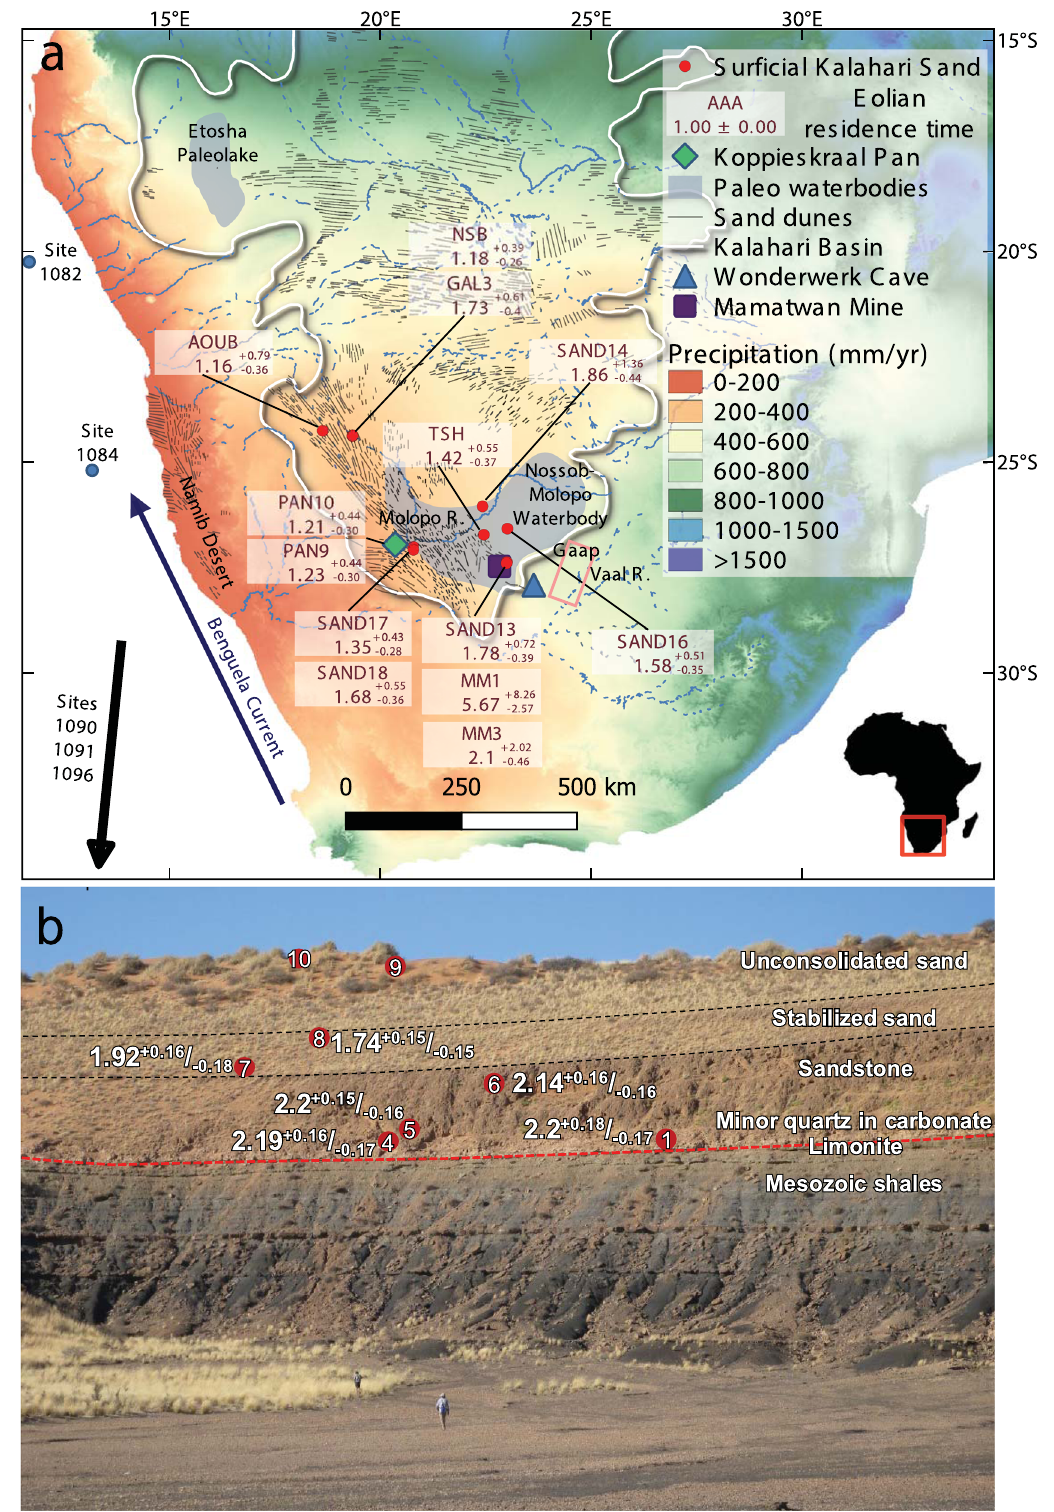
Fig. 1 | Eolian chronology of the Kalahari Desert Sand. a Locations of sand samples and sites mentioned in the text are superimposed on the modern pre- cipitation mapofsouthernAfrica (mapmade with QGIS. Climate data isfrom Fick, S.E. and R.J. Hijmans. WorldClim 2: new1kmspatial resolution climate surfaces for global land areas. International Journal of Climatology 37 (12): 4302 – 4315, 2017). Eolian residence time is the weighted average of the simulated duration in which agreement between simulated and measured radionuclides was achieved and is marked with a black line in Fig. 2. Inset: the red rectangle depicts the area of the